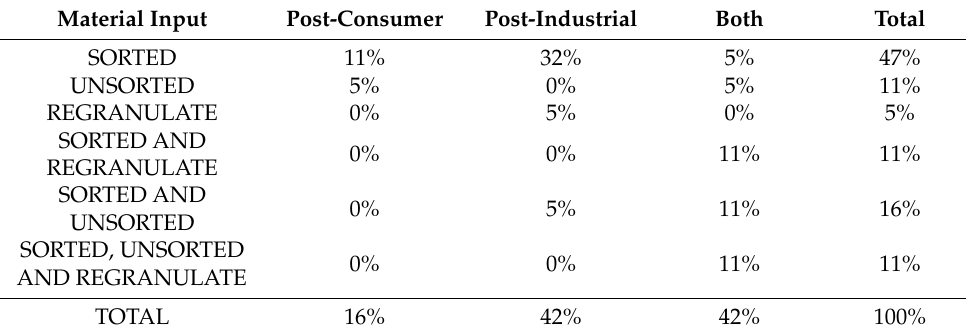
Table 3. Material input for recycler and